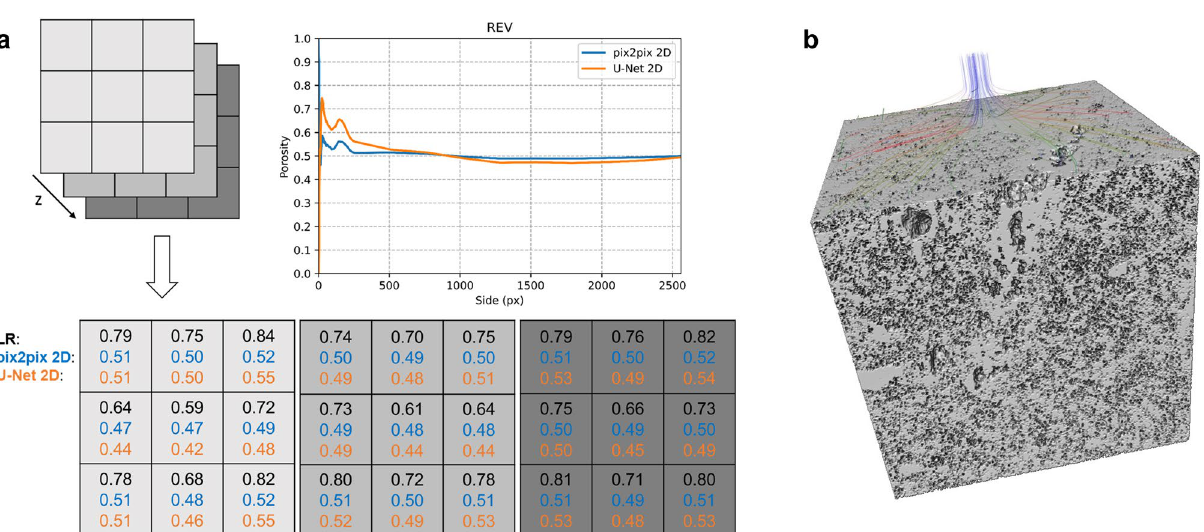
Figure 6. Petrophysical features of the super-resolved large tuff core. Petrophysical measurements performed on the super-resolved images (2560 3 px) obtained applying the best trained networks, 2D pix2pix and U-Net trained on paired data, to a large LR image (central 640 3 px; see Fig. 5). ( a ) Porosity values estimated using the box-counting method to calculate the minimum Representative Elementary Volume, REV (top), as well as dividing the super-resolved images in adjacent representative (i.e., larger than the minimum REV) subvolumes to detect potential heterogeneities (bottom). ( b ) Example of 3D super-resolved (2D U-Net) and segmented image employed for intrinsic permeability simulations (central 900 3 px, the maximum volume exploitable for our computational